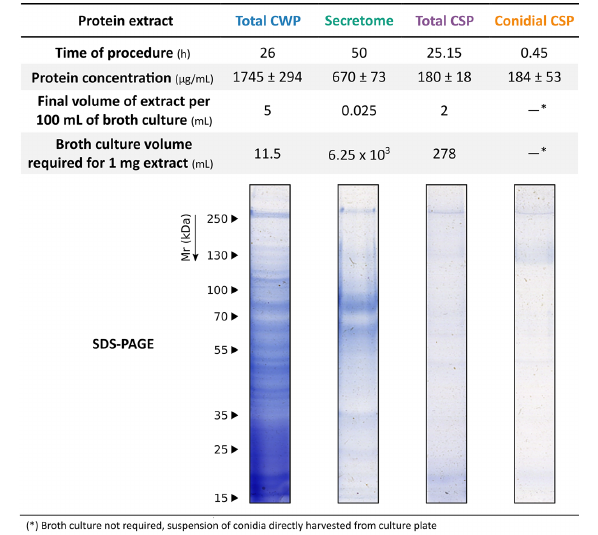
FIGURE 4 | Evaluation of the ef fi ciency of the methods for obtaining the different protein extracts of S. boydii. Approximate performance values of